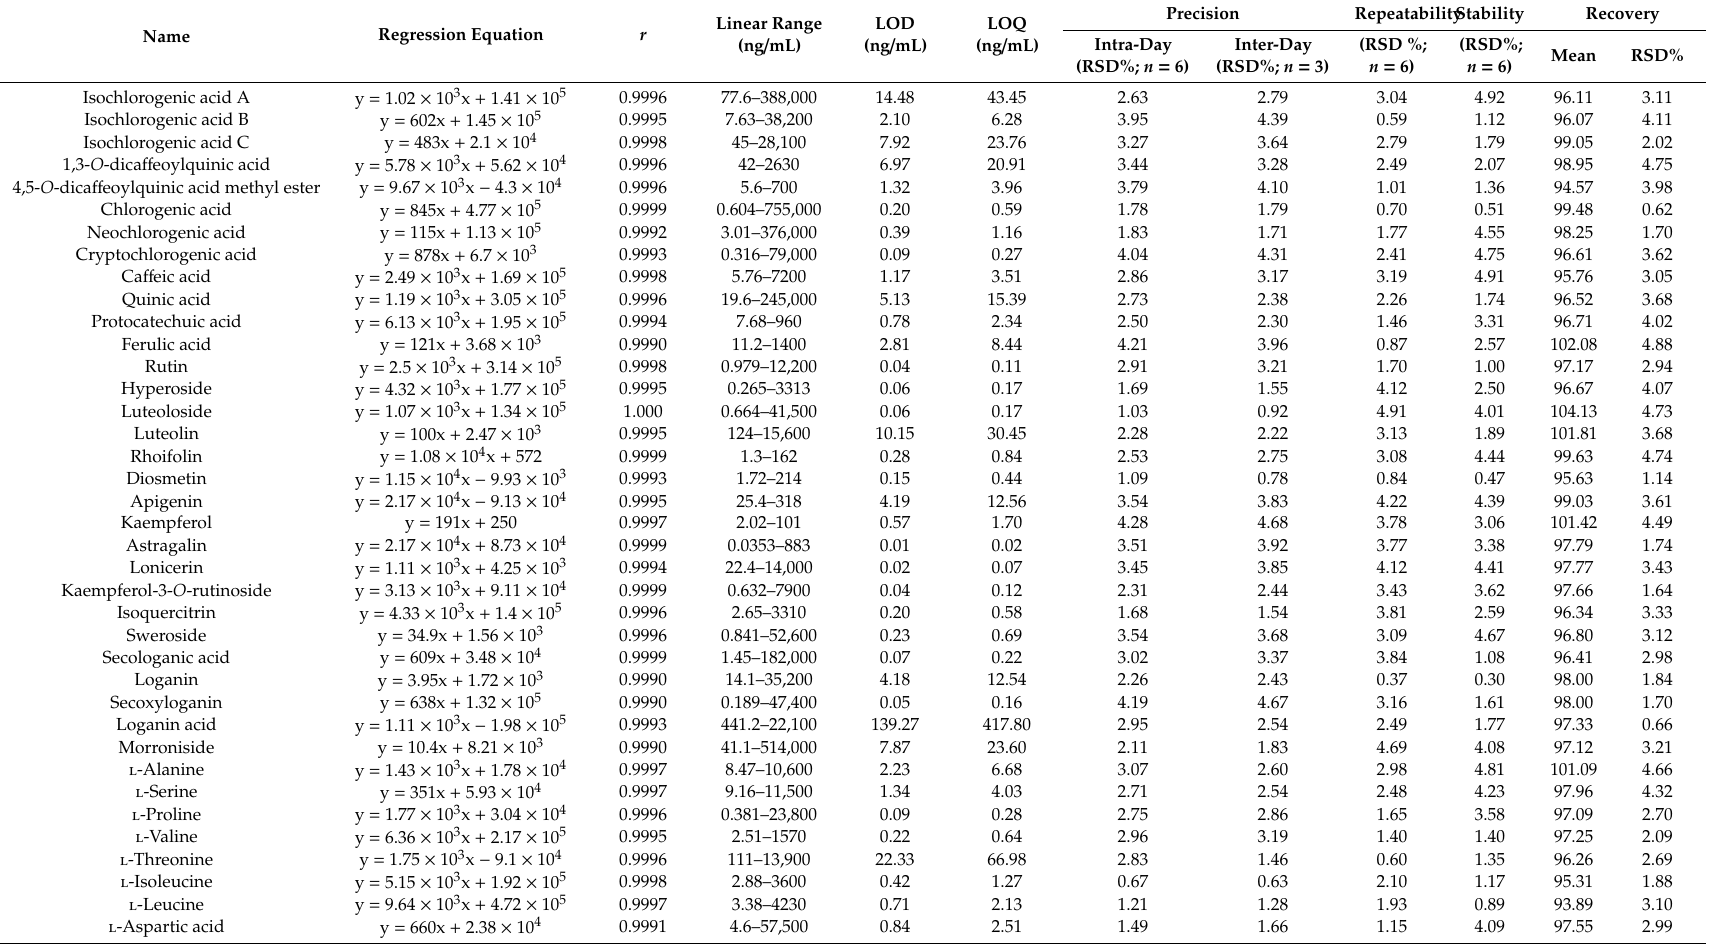
Table 3. Regression equations, limits of detections (LODs), limits of quantifications (LOQs), intra- and inter-day precisions, repeatability, stabilities, and recoveries of 47